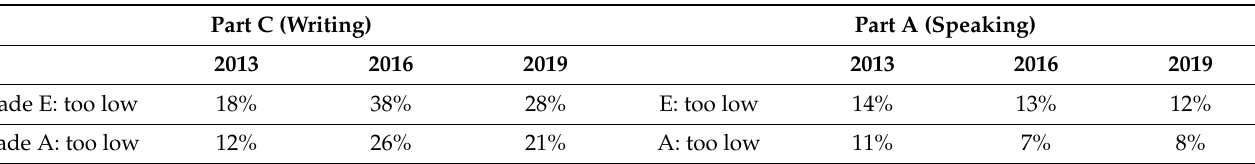
Table 8. Teacher responses to the statement ‘The assessment of the examples/benchmarks is . . . ’ (Part C; Part A; 2013: n = 1042; 2016: n = 394; 2019: n = 501).